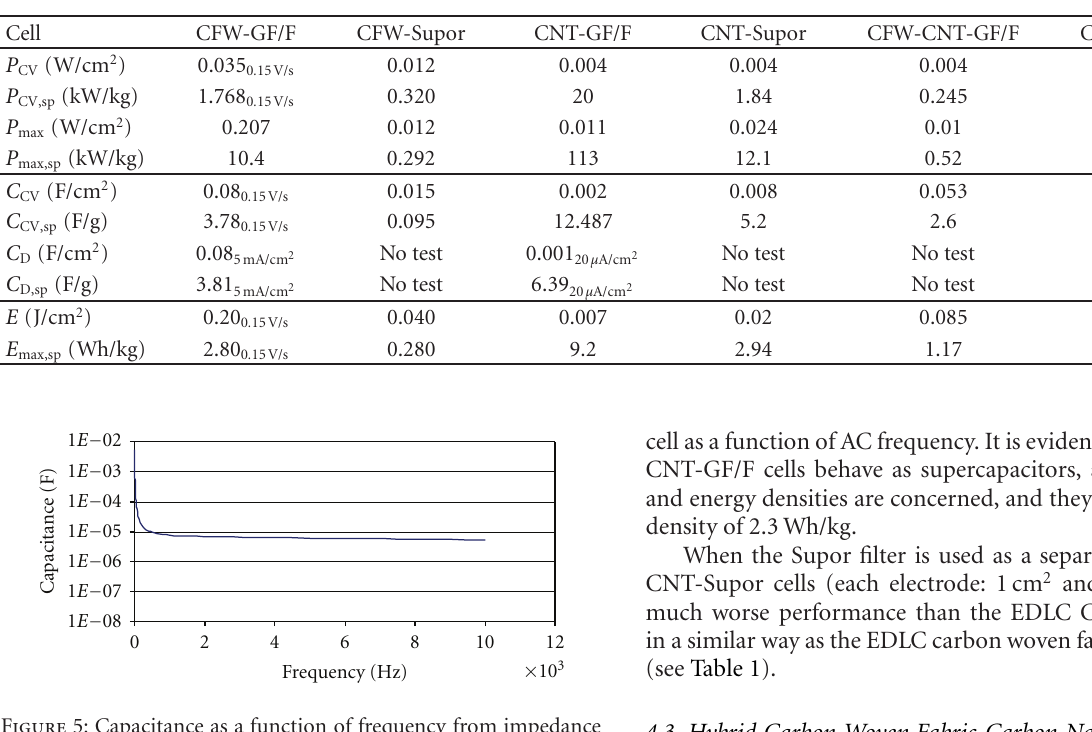
Table 1: Summary of performance results of the various types of electrodes combined with two di ff erent types of separators. ( P CV : power from cyclic voltametry 0 to 2.5V at 0.2 V/s. P CV, sp : power density from cyclic voltametry at 0.2V/s. P max : maximum power on the basis of the ESR determined from the impedance test. P max, sp : maximum power density. E max : maximum energy. E max, sp : maximum energy density).